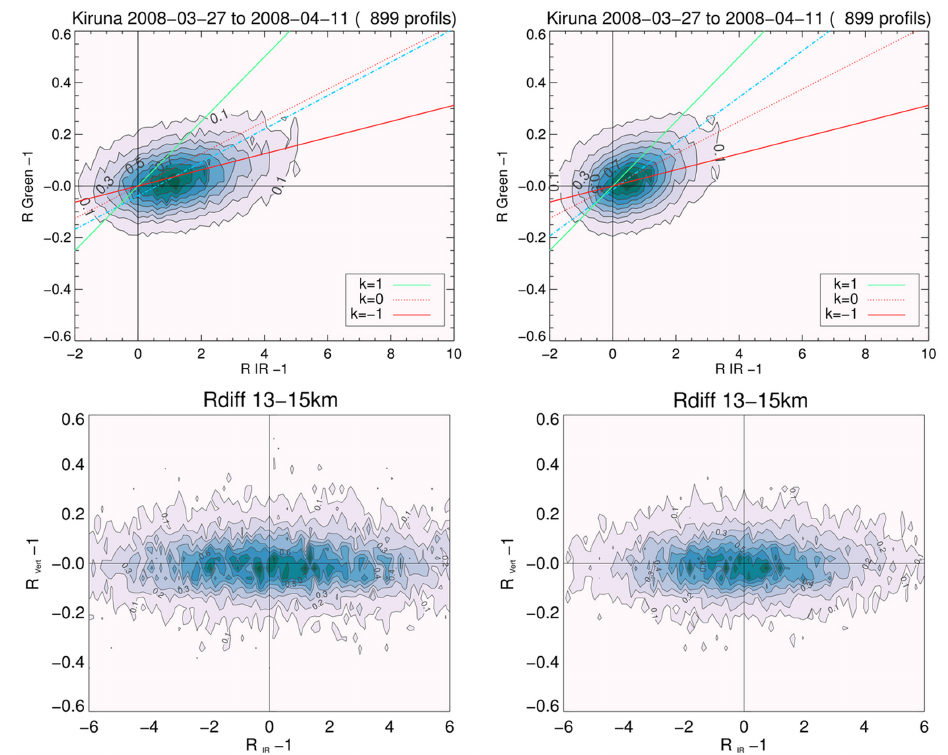
Figure 7. Correlation between the 532 and 1064nm filtered level 1 CALIOP backscatter ratio from 27 March to 11 April 2008, at altitudes from 0 to 7km (top row) and 13 to 15km (bottom row) using either uncorrected (left) or corrected (right) IR backscatter data. Regression line is the dashed-dotted blue line. The lines k = − 1, 0, 1 are for tropospheric aerosol distributions with CR a = 2, 1, 0.5m, respectively.